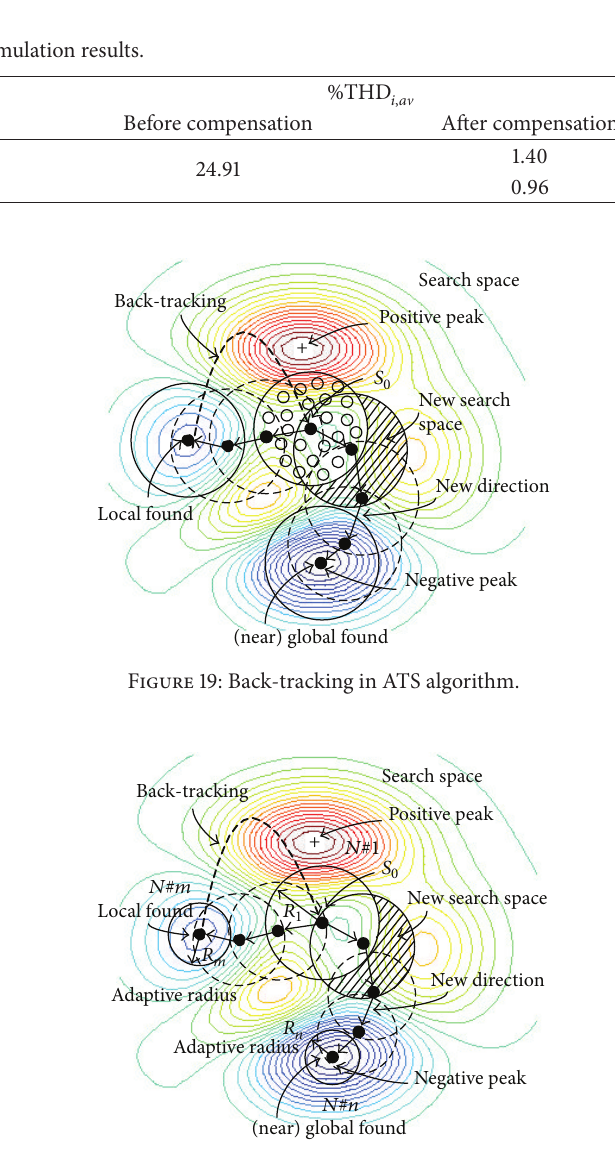
Figure 20: ATS algorithm with adaptive search radius